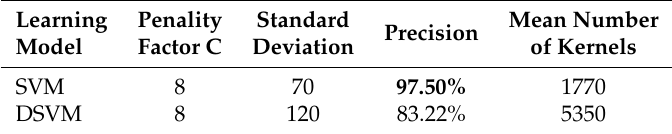
Table 4. Optimal parameters for the models for the 800 × 800 resolution scenes. The bold value simply indicates the maximum